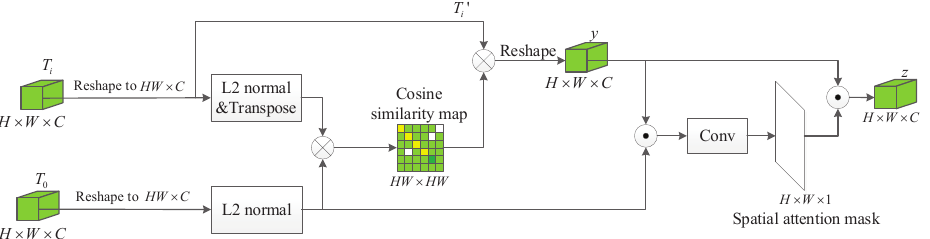
Figure 4. The feature-aligned (FA) module has two inputs: T 0 indicates the initial template feature and T i is extracted from the predicted target location. The feature-reconstructed network is on the left and the spatial attention network is on the